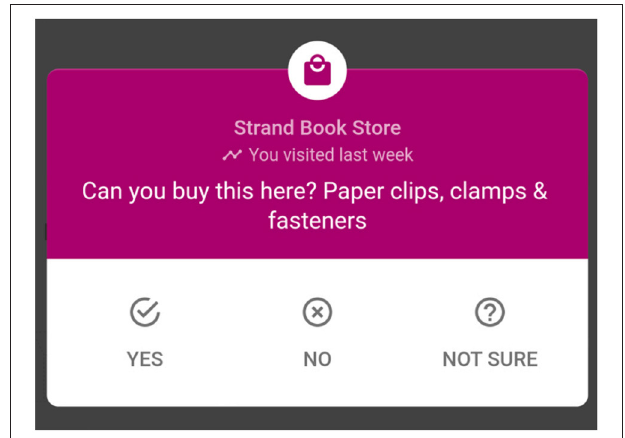
FIGURE 3 | Example question used to gather